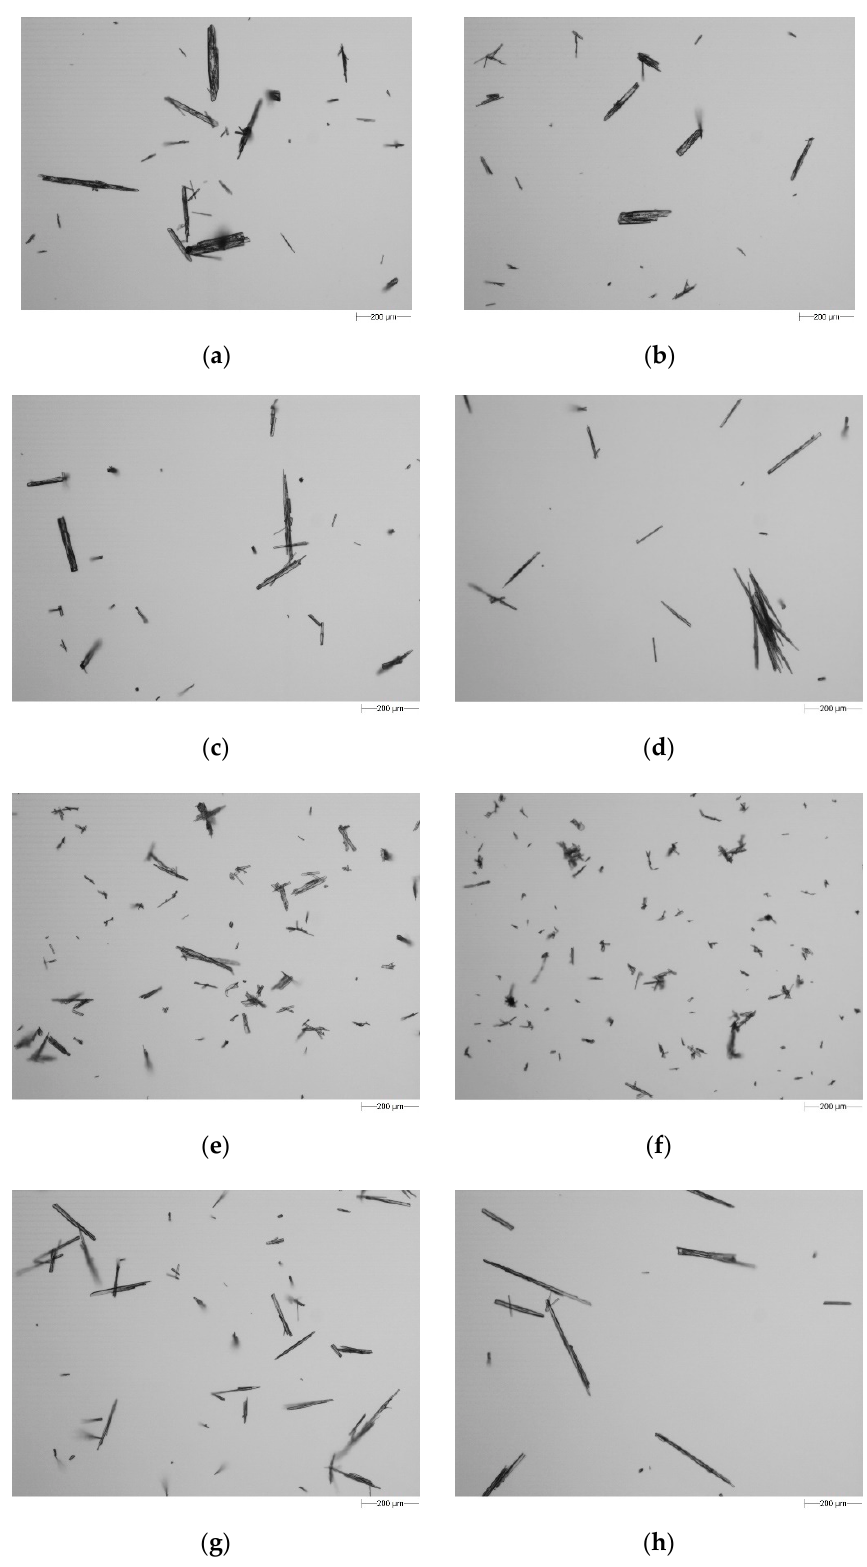
Figure 8. Microscope images of the crystals from experiments 1–8 are shown in ( a – h ), respectively. The image in ( f ) confirms that the conditions used in Experiment 6 produce the smallest and least needle-like crystals.